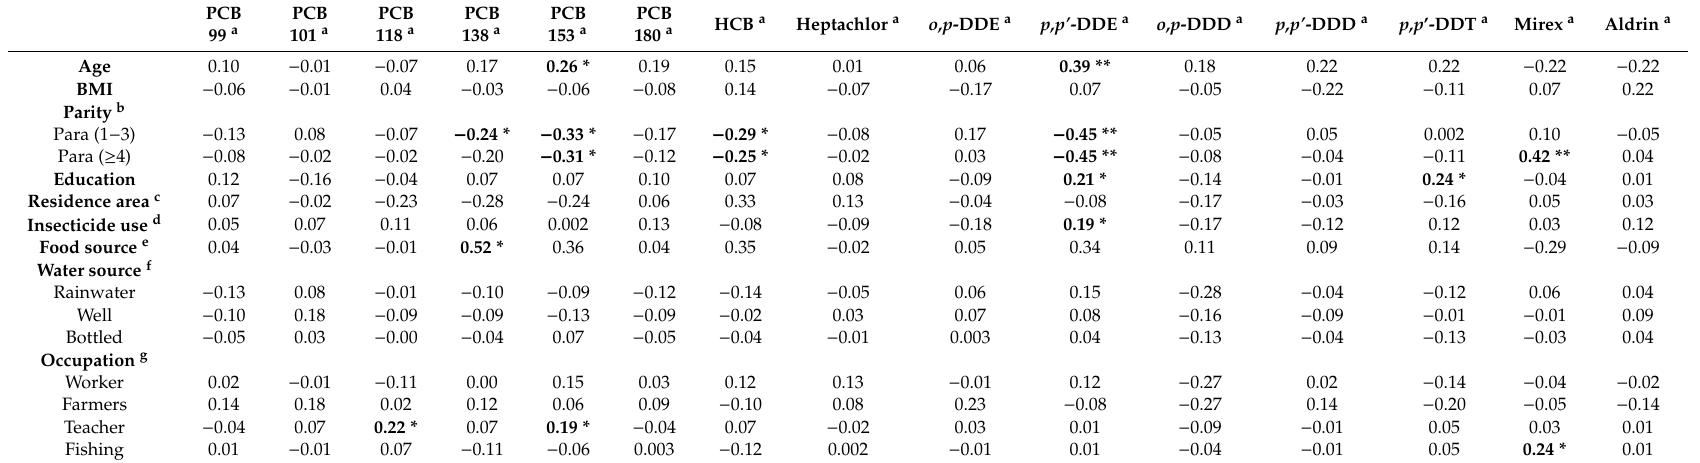
Table 3. Multiple linear regression models showing the associations of sociodemographic and other maternal variables with maternal organochlorine (OC)